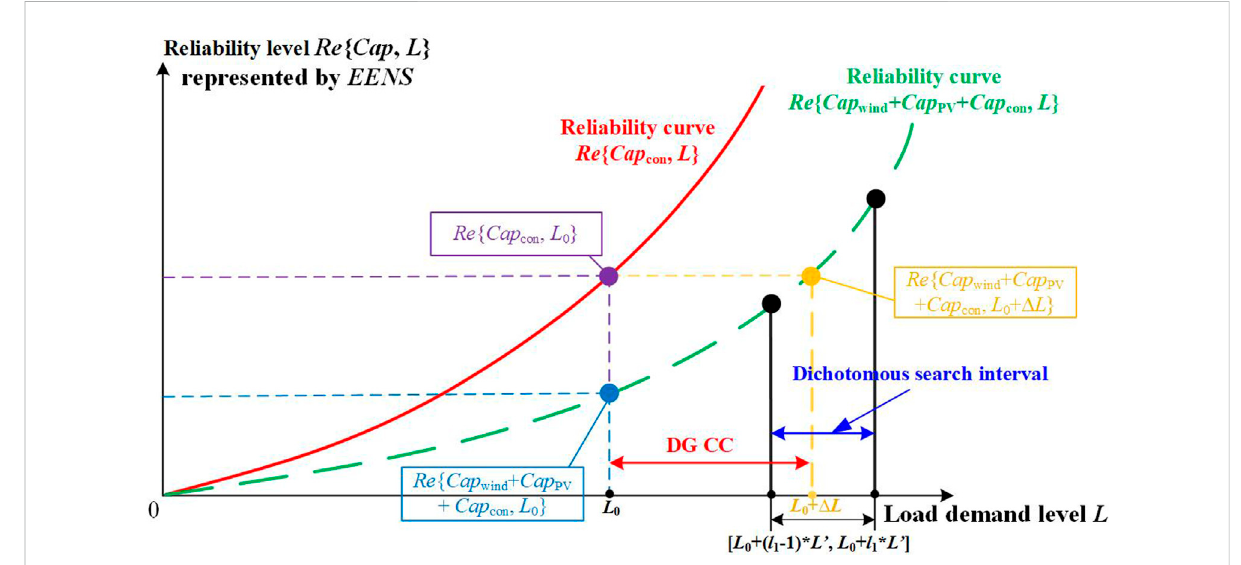
FIGURE 1 The schematic diagram of CC